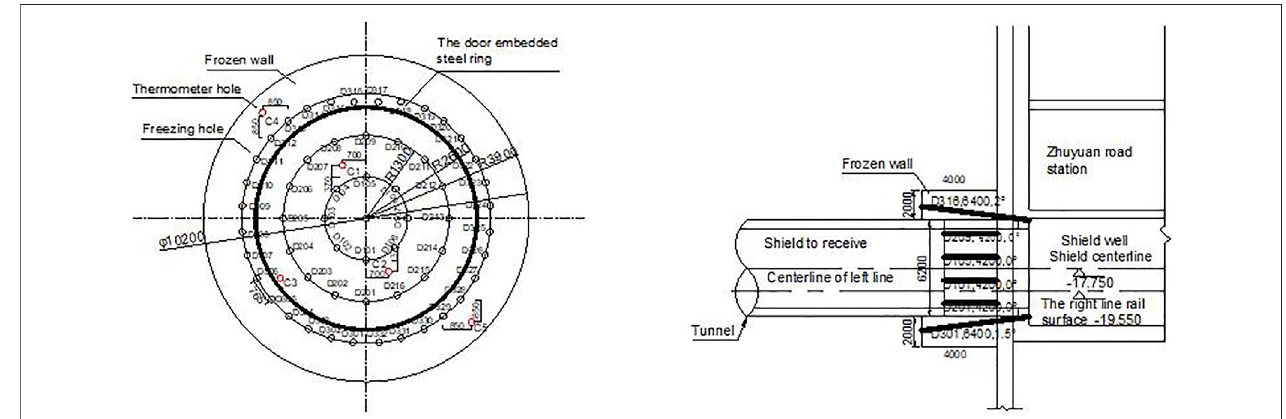
FIGURE 5 | Frozen hole and temperature hole layout (unit: mm): (A) elevation view and (B) sectional view.